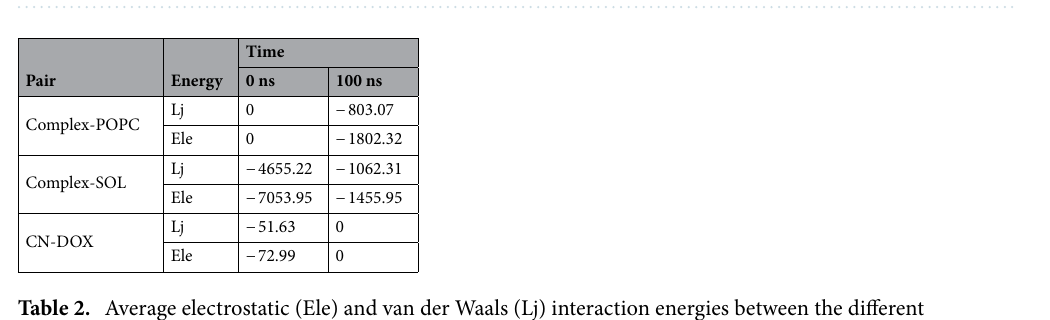
Figure 11. Evolution of the progressive insertion of CN-DOX into the lipid bilayer at two times of the simulation. ( a ) 0 ns, ( b ) 100 ns.